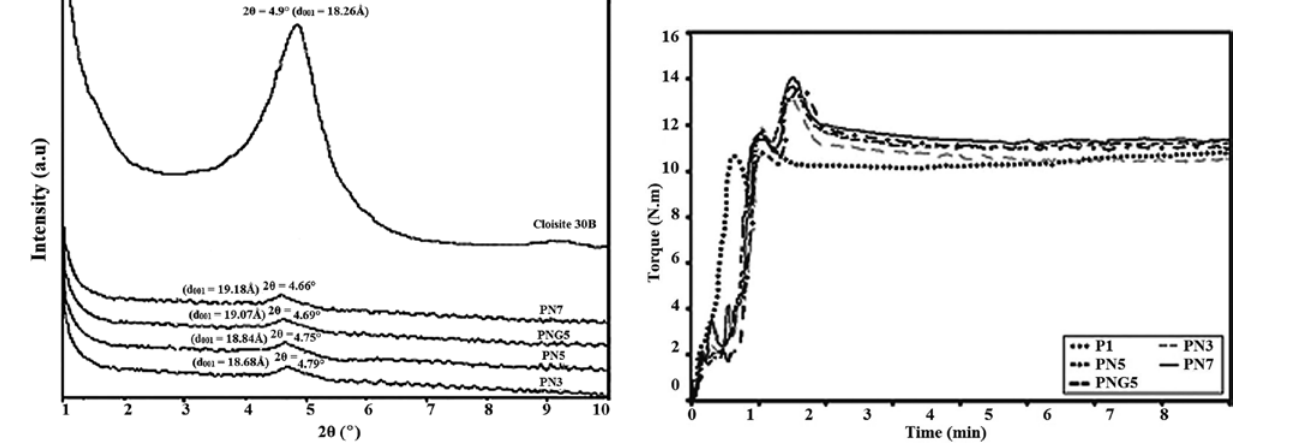
Figure 3: X-ray diffractograms of Cloisite ® 30B, and PN3, PN5, PN7, and PNG5 nanocomposites.